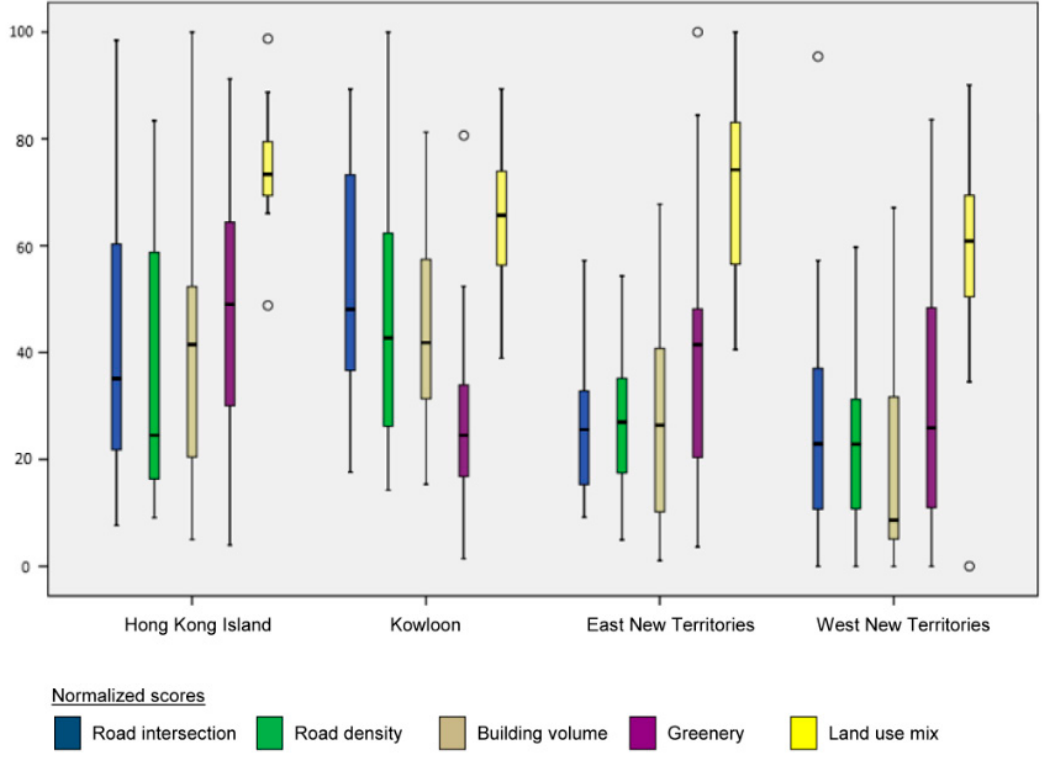
Figure 4. Box plots of morphological metrics (based on normalized scores) by geographic regions of Hong Kong.